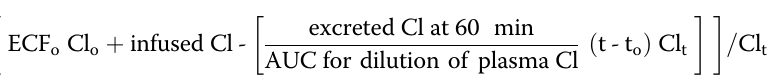
Correction for losses and additions of Cl was done by taking the total amount of (as given by the electrolyte equa- chloride in the ECF volume as the product of ECF o to which the infused amount of chloride was added. Losses of chloride tion) and Cl o were taken as the total excreted amount at 60 min divided by the area under the curve (AUC) for the dilution of plasma Cl but considering only a fraction of AUC for the time segment up to each time t [4]. Hence, the volume of distribution of Cl, which is and represented by the symbol v , was given by: chloride amount/Cl t (cid:2) (cid:3)(cid:2) (cid:3) excreted Cl at 60 min = Cl ECF o Cl o þ infused Cl - t - t o ð Þ Cl t t AUC for dilution of plasma Cl where each of the 9 time segments are denoted ( t − t ). ECF was the key outcome o o measure of the subsequent volume kinetic calculation. The kinetic calculations were